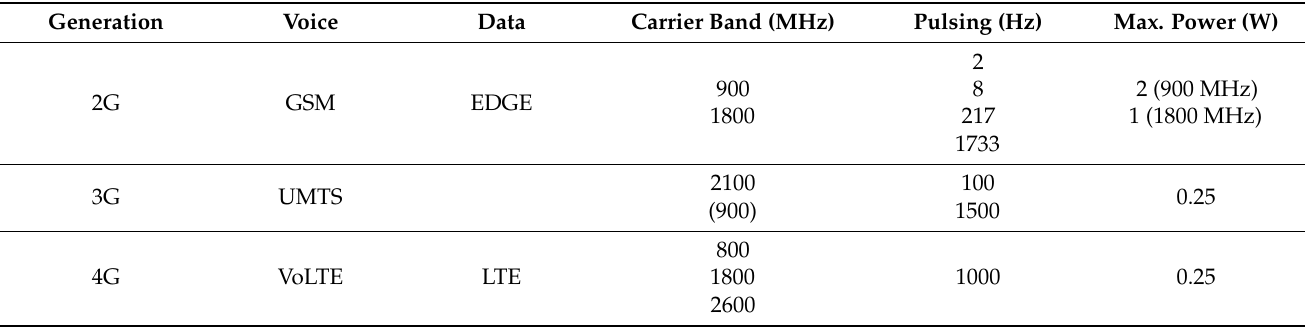
Table 4. Main characteristics of mobile telephony and data systems in Europe.